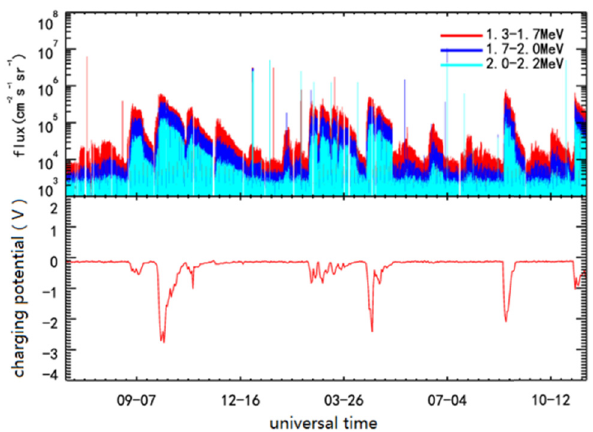
Figure 12: The monitoring results of satellite deep charging